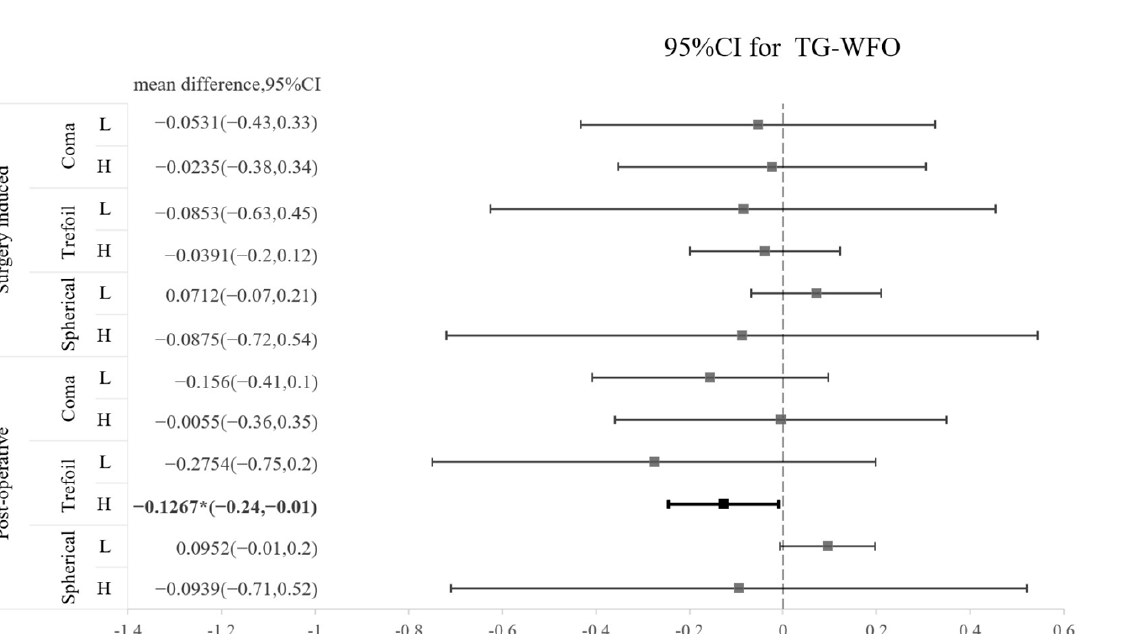
TG: topography-guided; WFO: wavefront-optimized; LASIK: laser in situ keratomileusis. Wilcoxon matched-pairs signed rank test: * p < 0.05.